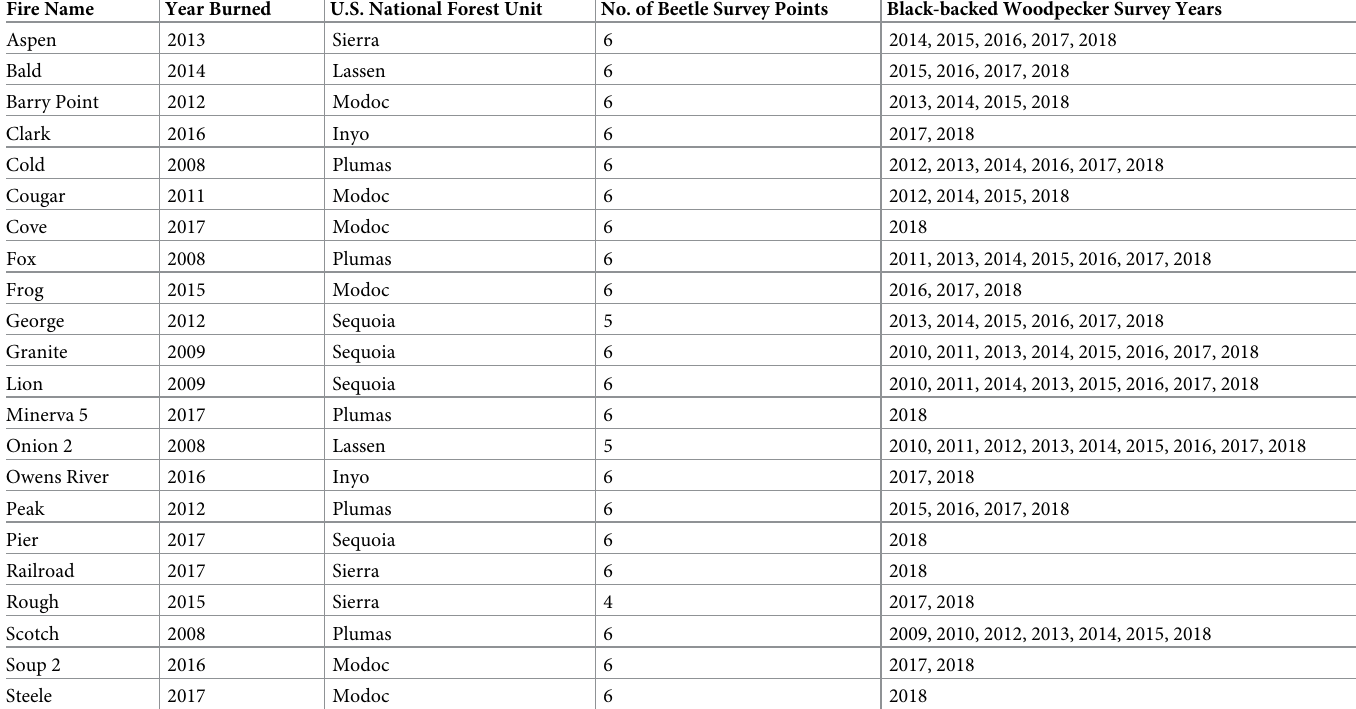
Table 1. Fires surveyed for both black-backed woodpeckers and woodboring beetles. Beetle surveys were conducted in 2018 and woodpecker surveys were conducted in 2018 and up to 8 additional years